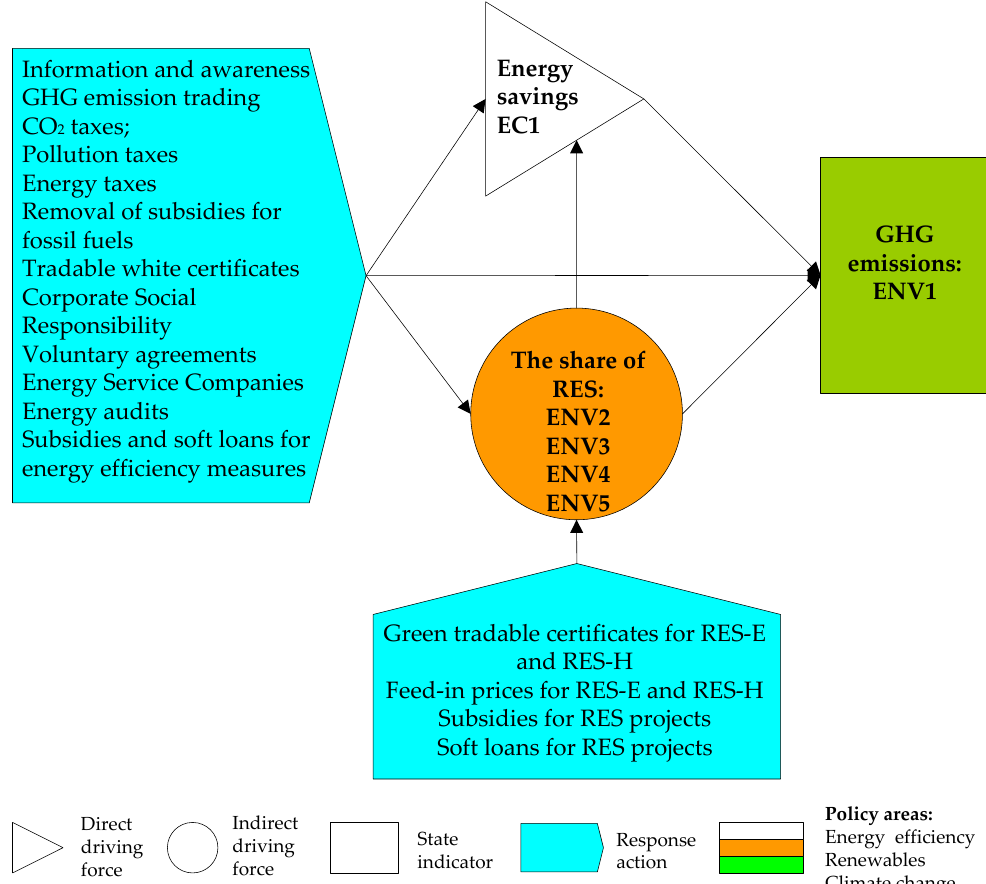
Figure 2. Linkages between sustainable energy indicators and policy actions including corporate responsibility (CSR) of energy social responsibility (CSR) of energy utilities.